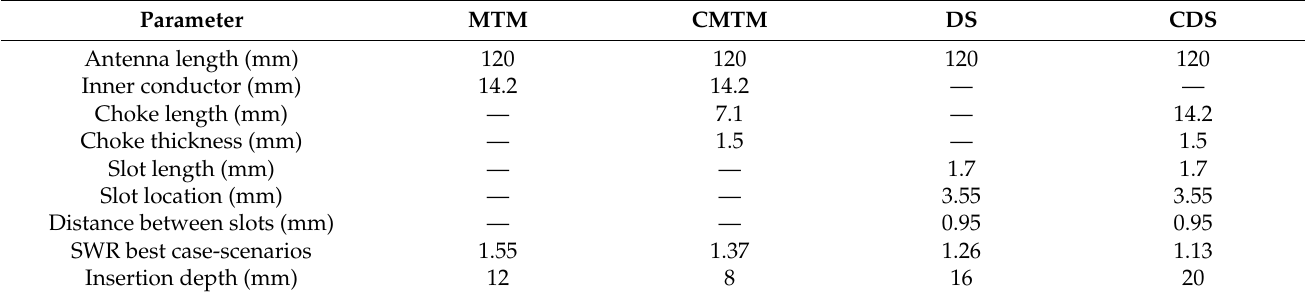
Table 4. Geometry dimension for each optimized